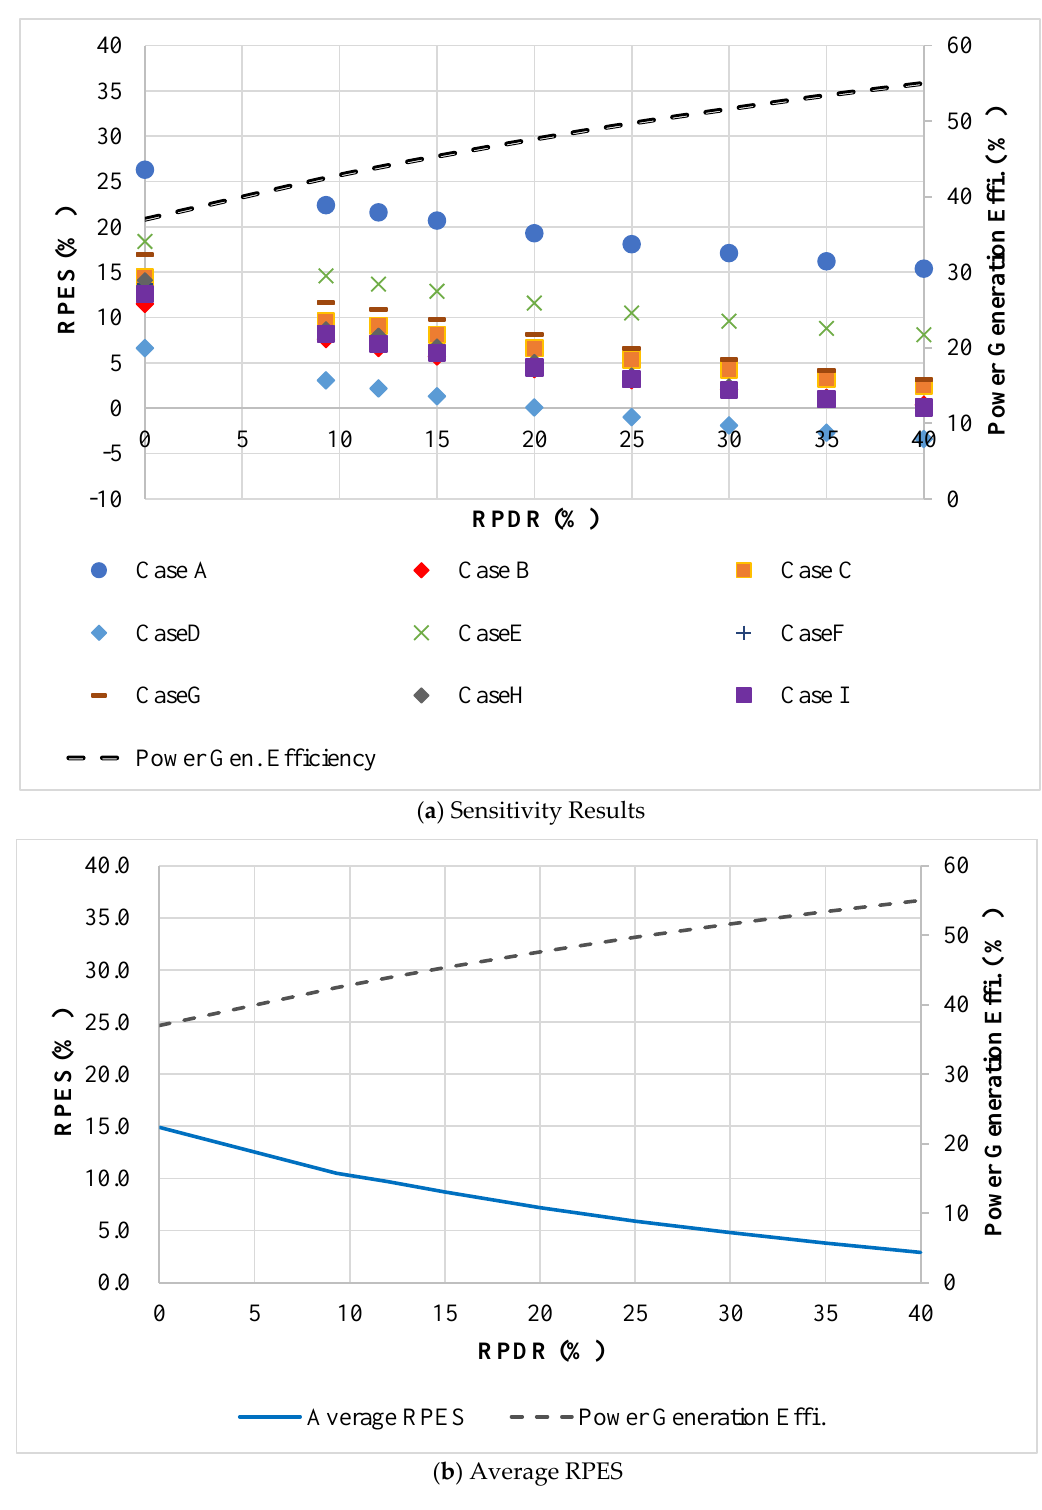
Figure 19. Change of the RPES by case according to the change of RPDR. Table 6. Reference values of the operating parameters for RPES evaluation.